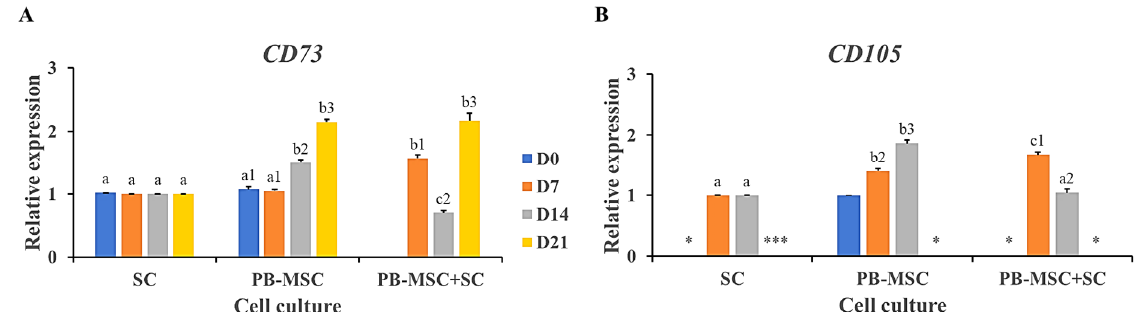
Figure 6. Expression of MSC markers CD73 and CD105 in single cultures and co-cultures of bull PB- MSC with SC in 3D SACS for 21 days. ( A ) MSC+SC co-culture down-regulated ( p < 0.05) CD73 gene expression on day 14. ( B ) CD105 gene expression was down-regulated ( p < 0.05) in the PB-MSC+SC on day 14 compared to PB-MSC. CD105 gene expression was not detected in any culture at day 21. (*) Indicate gene expression was not detected in a single sampling day. Different superscripts (a, b, c) indicate differences ( p < 0.05) for the same marker between cell types and (1,2,3) for the same marker between days of culture.